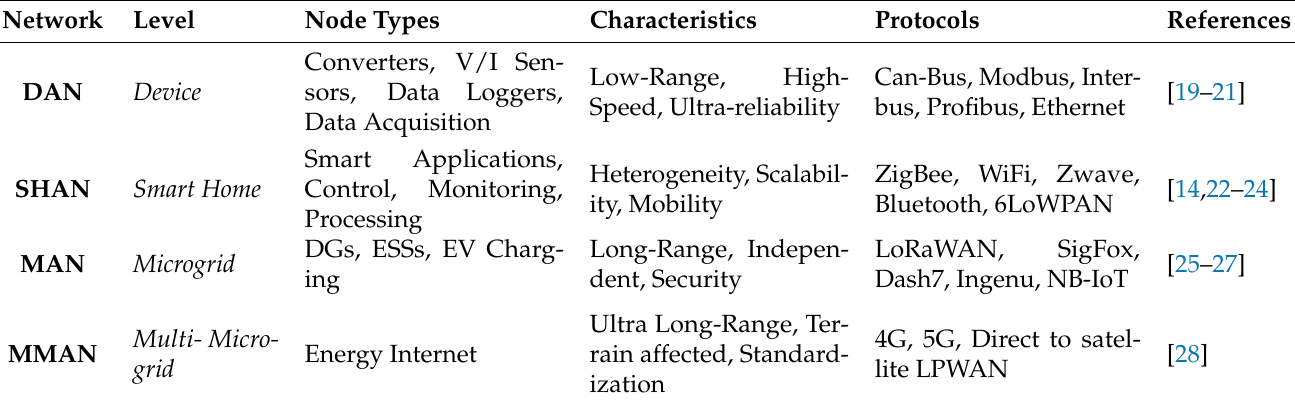
Figure 1. Multilevel communication network for a system of residential MGs for remote applications. Table 1. Different network levels, devices, communication requirements, and